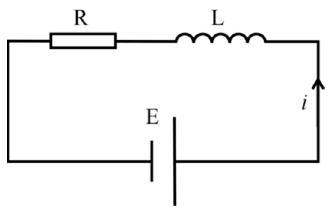
Figure 8. Simplified superconducting loop.